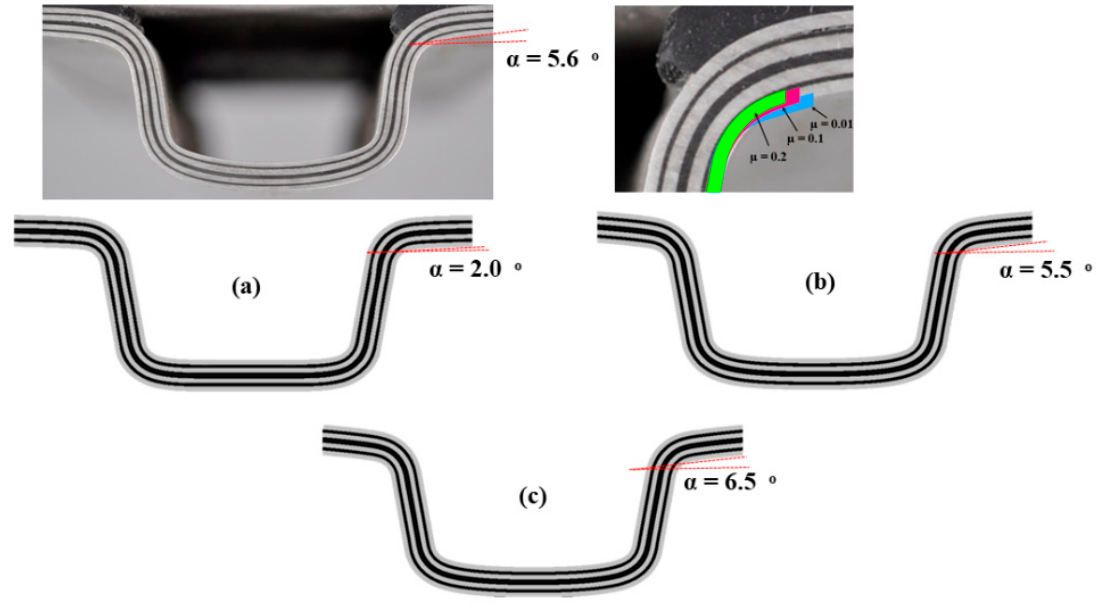
Figure 7. Influence of the inter-ply Coulomb coefficient on the α angle. ( a ) µ = 0.01, ( b ) µ = 0.1, and ( c ) µ = 0.2.